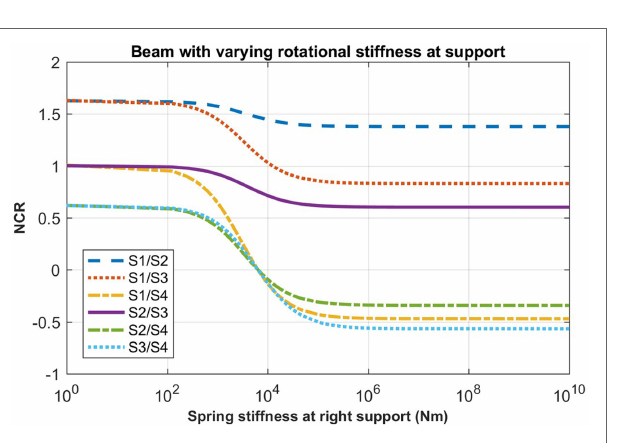
FIGURE 6 | Case study: NCRs of beam with varying rotational stiffness at